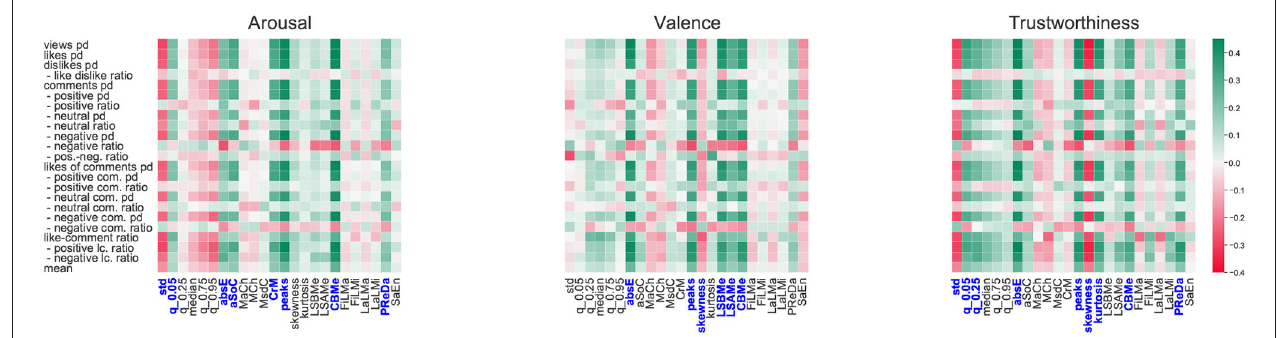
FIGURE 4 | Pearson correlation matrix of user engagement indicators and the statistics/ features extracted from each dimension. The latter are standard deviation ( std ), quantile ( q x ), absolute energy ( absE ), mean absolute change ( MACh ), mean change ( MCh ), mean central approximation of the second derivatives ( MSDC ), crossings of a point m ( CrM ), peaks, skewness, kurtosis, strike above the mean ( LSAMe ), strike below the mean ( LSBMe ), count below mean ( CBMe ), absolute sum of changes ( ASOC ), first and last location of the minimum and maximum ( FLMi , LLMi , FLMa , FLMa ), perc. of reoccurring datapoints ( PreDa ), and sample entropy ( SaEn ). Features in blue are utilized as cross-task, semi-automatic features for user engagement prediction.